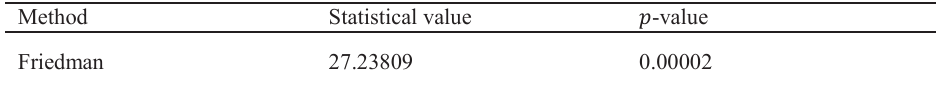
Table 20. Results of Friedman’s test based on the average best-so-far for multimodal test functions of set 2.